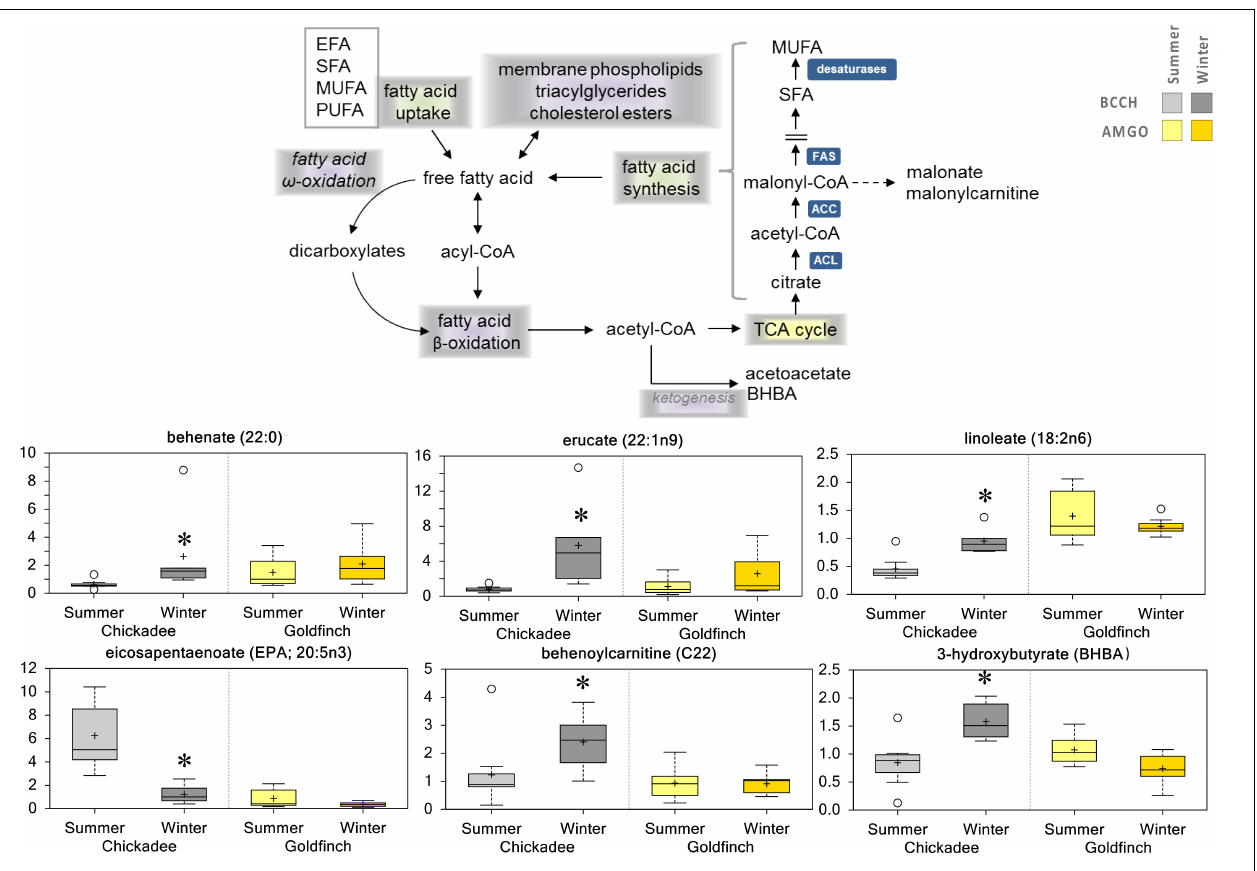
FIGURE 4 | Differences in the abundances of metabolites involved in lipid metabolism in pectoralis muscle of Black-Capped Chickadee (BCCH) and American Goldfinch (AMGO). The X -axis represents the species and the seasons sampled. The Y -axis box plots indicate the scaled intensity mean (+) and median (–) values: upper and lower ranges of boxes indicate upper and lower quartiles, respectively; upper and lower whiskers indicate the maximum and minimum distributions of the data; small circles represent outlying data points. ∗ Significantly ( p < 0.05 and q < 0.10) different compared to the other season within the